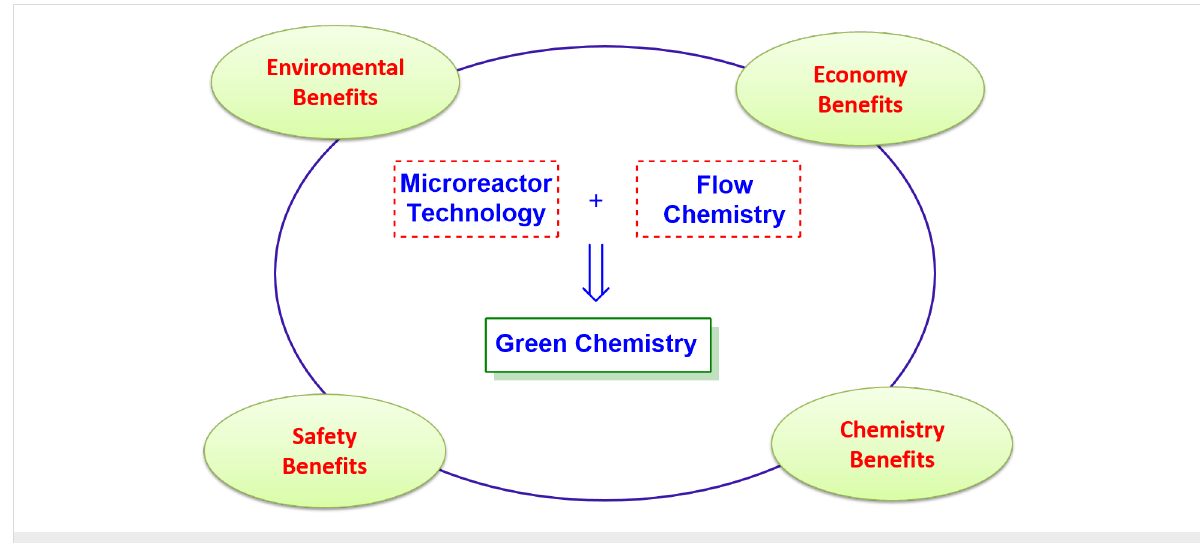
Figure 1: Microreactor technologies and flow chemistry for a sustainable chemistry.